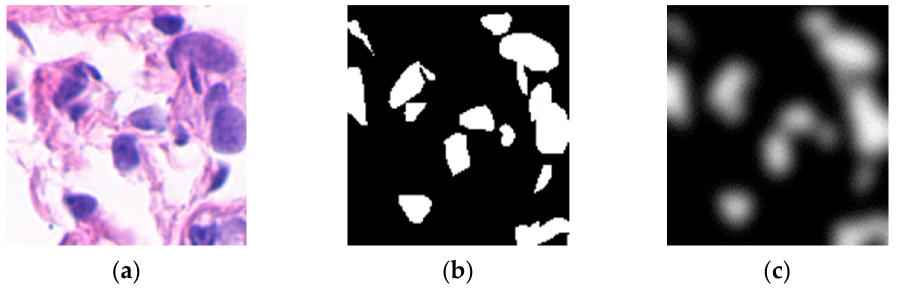
Figure 2. ( a ) A pathological tissue patch. ( b ) Hard segmentation result of ( a ). ( c ) Soft segmentation result of ( a ).